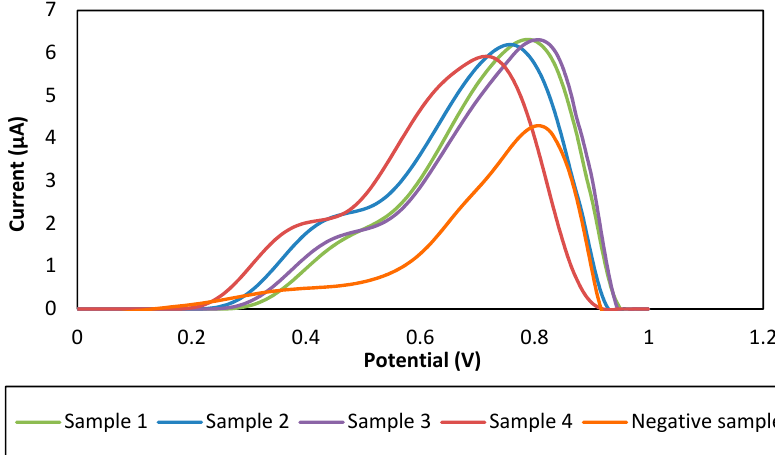
Figure 7. DPV response of sandwich electrochemical immunosensor for CFP10 detection using GP/PANI-modified SPGE in real sample application.